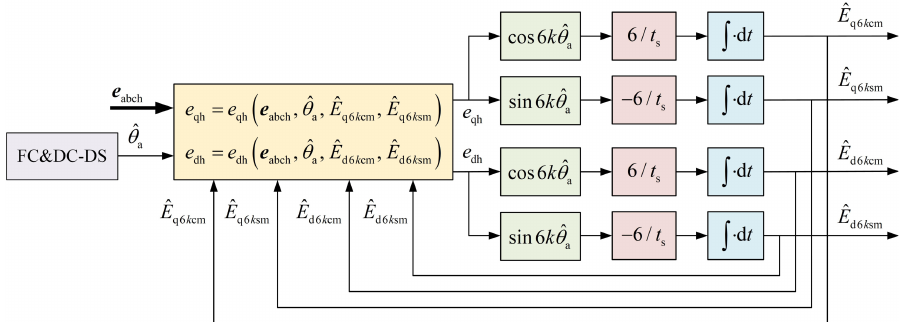
Figure 5. The higher-harmonic components (HC)-DS in detection of the higher-harmonic voltage parameters.